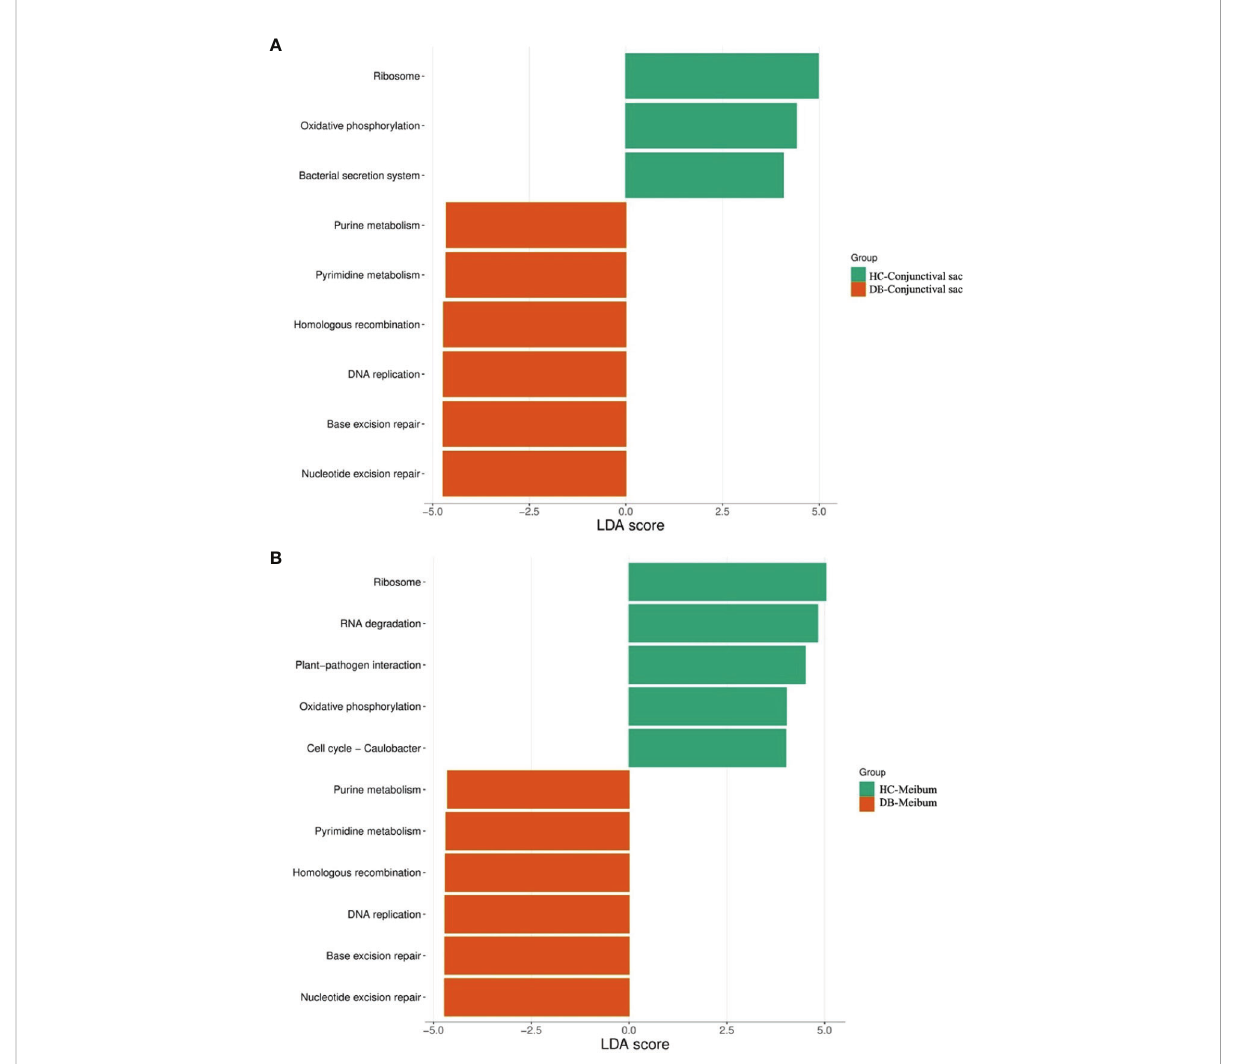
FIGURE 6 Discriminative Kyoto encyclopedia of genes and Genomes pathways in the conjunctival sac microbiome (A) and meibum microbiome (B) of the controls and Demodex blepharitis groups. HC, Healthy control; DB, Demodex